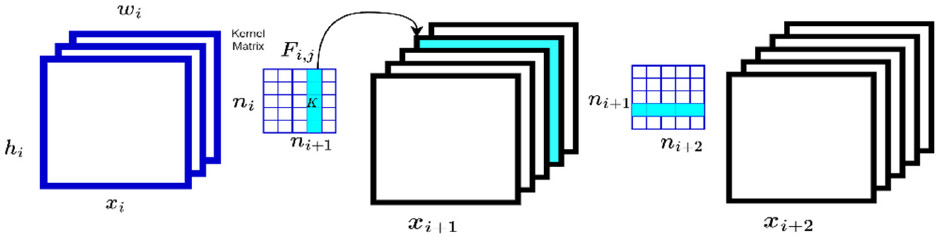
Figure 2. Compression technique using pruning filters.